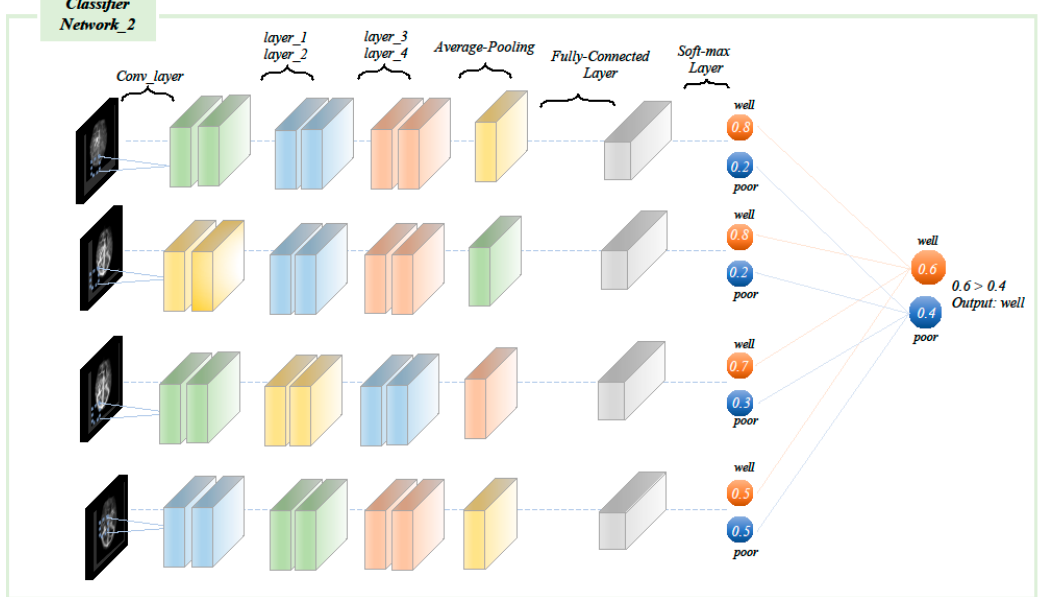
Figure 6. Multi-image input processing network statistical analysis and model testing. The images of each different phase were separately input into the network of the same structure, each branch produced a classification result, and the final result was calculated by the weighted average.